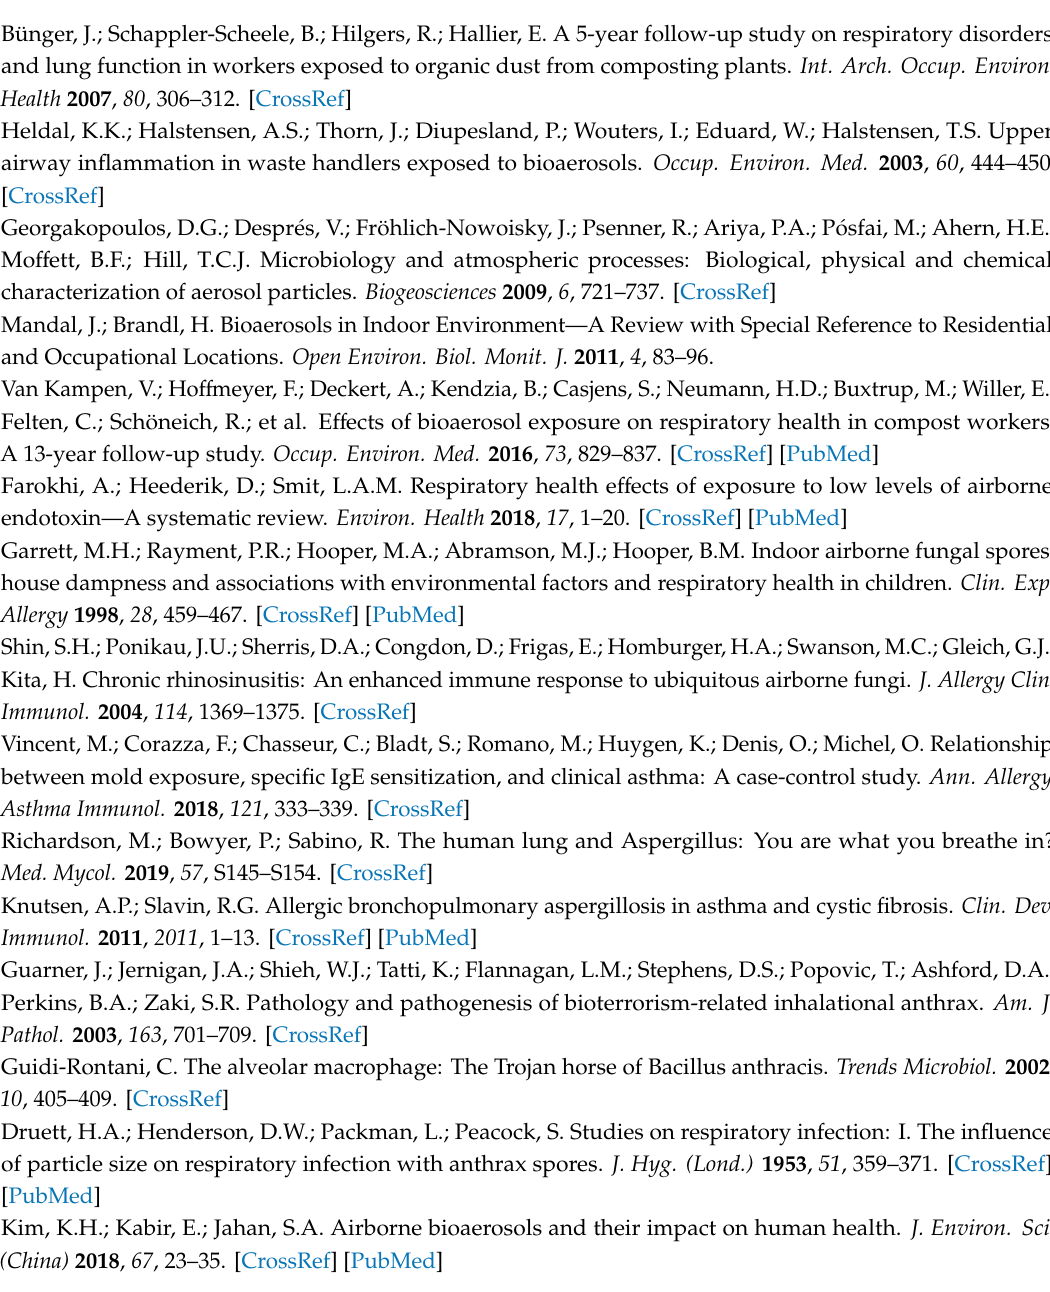
exercise scenario. Table S4: Deposition fraction as a function of height and associated breathing parameters, mouth breathing